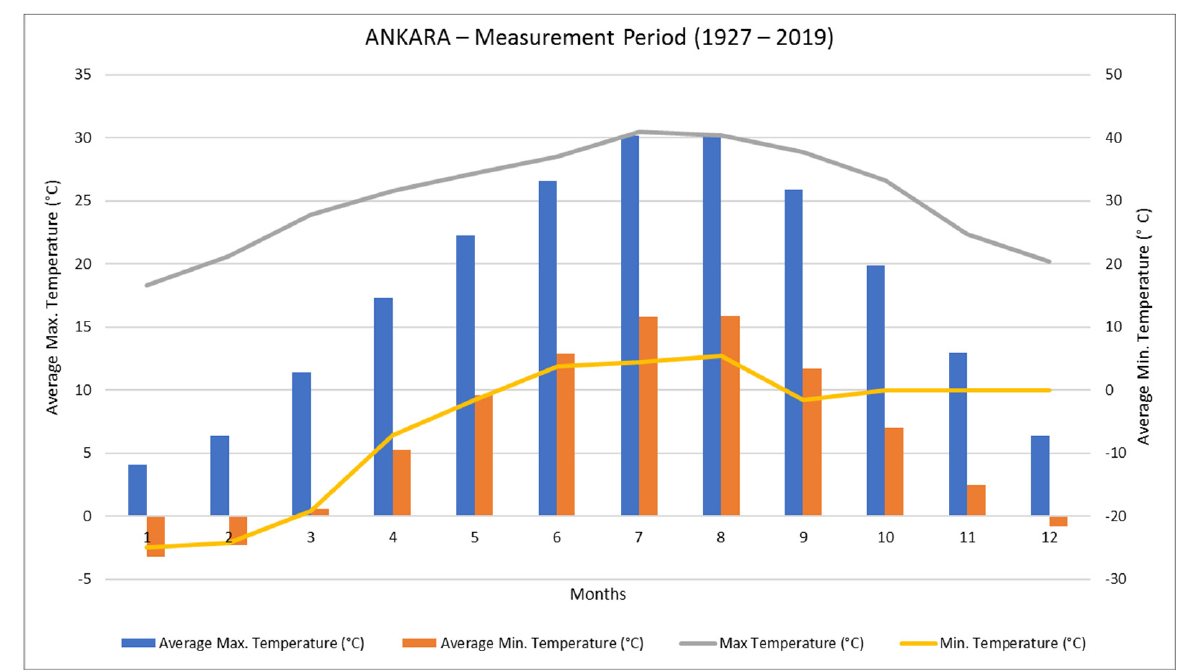
Figure 5. Annual temperature values of the Ankara (TSS 2021).